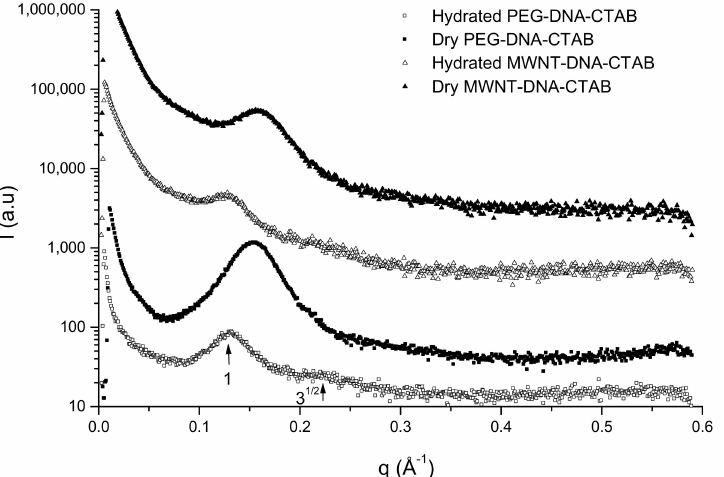
Figure 6. SAXS spectra of the dry (solid symbols) and hydrated (open symbols) gel particles. The arrows show the first and the second peaks of the hexagonal packing. The spectra are scaled for